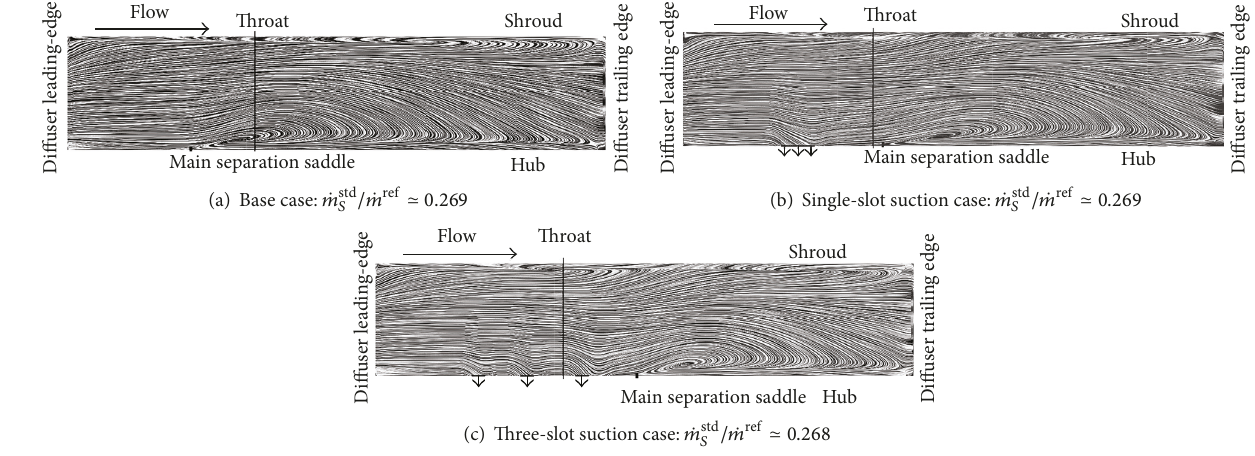
Figure 6: Skin-friction on the diffuser suction